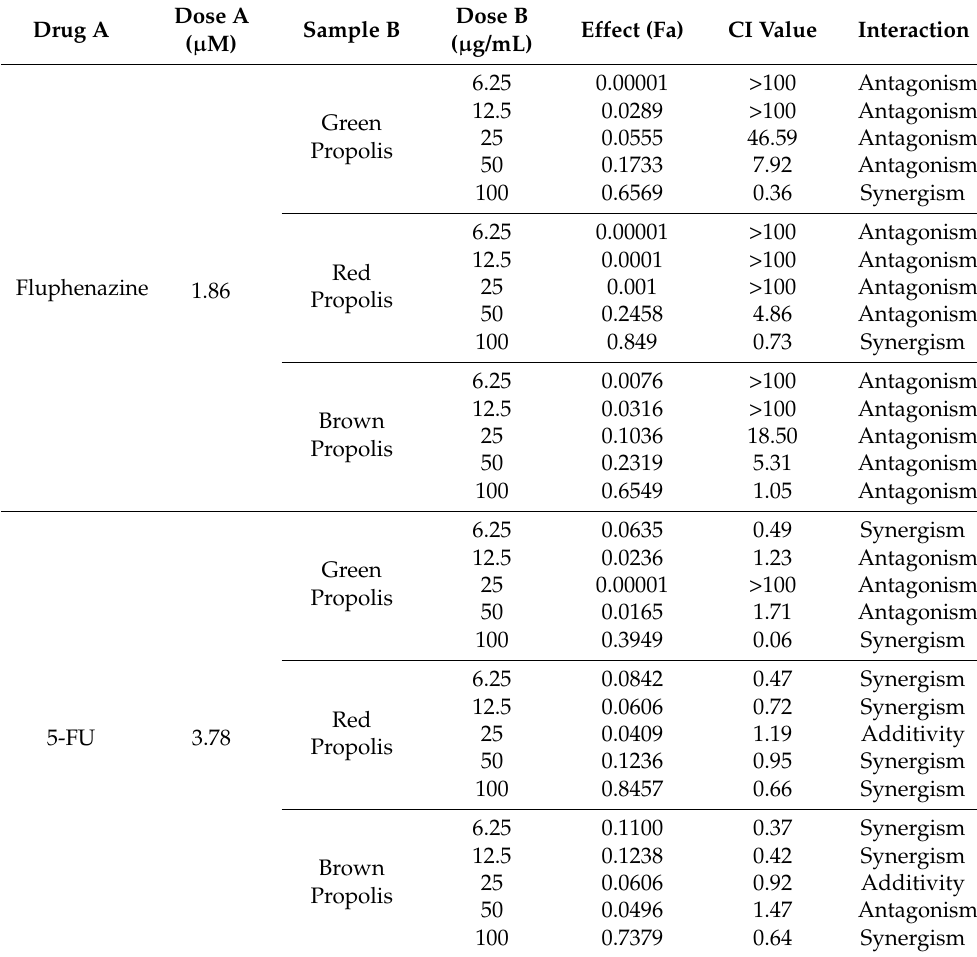
Table 5. Nature of drug interactions in HT-29 colon cancer cells treated with fluphenazine and 5-FU combined with green, red and brown propolis.